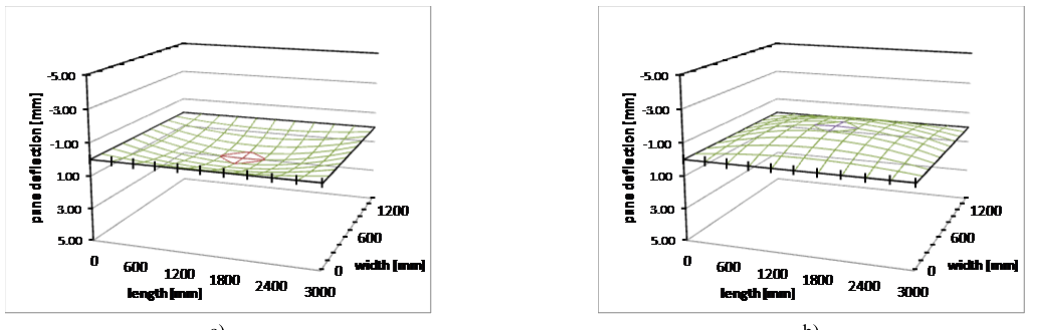
Fig. 11 Deflection of IGU glass panes (1500 x 3000 mm) with Ködispace 4SG spacer, a) ext. pane, b) int.